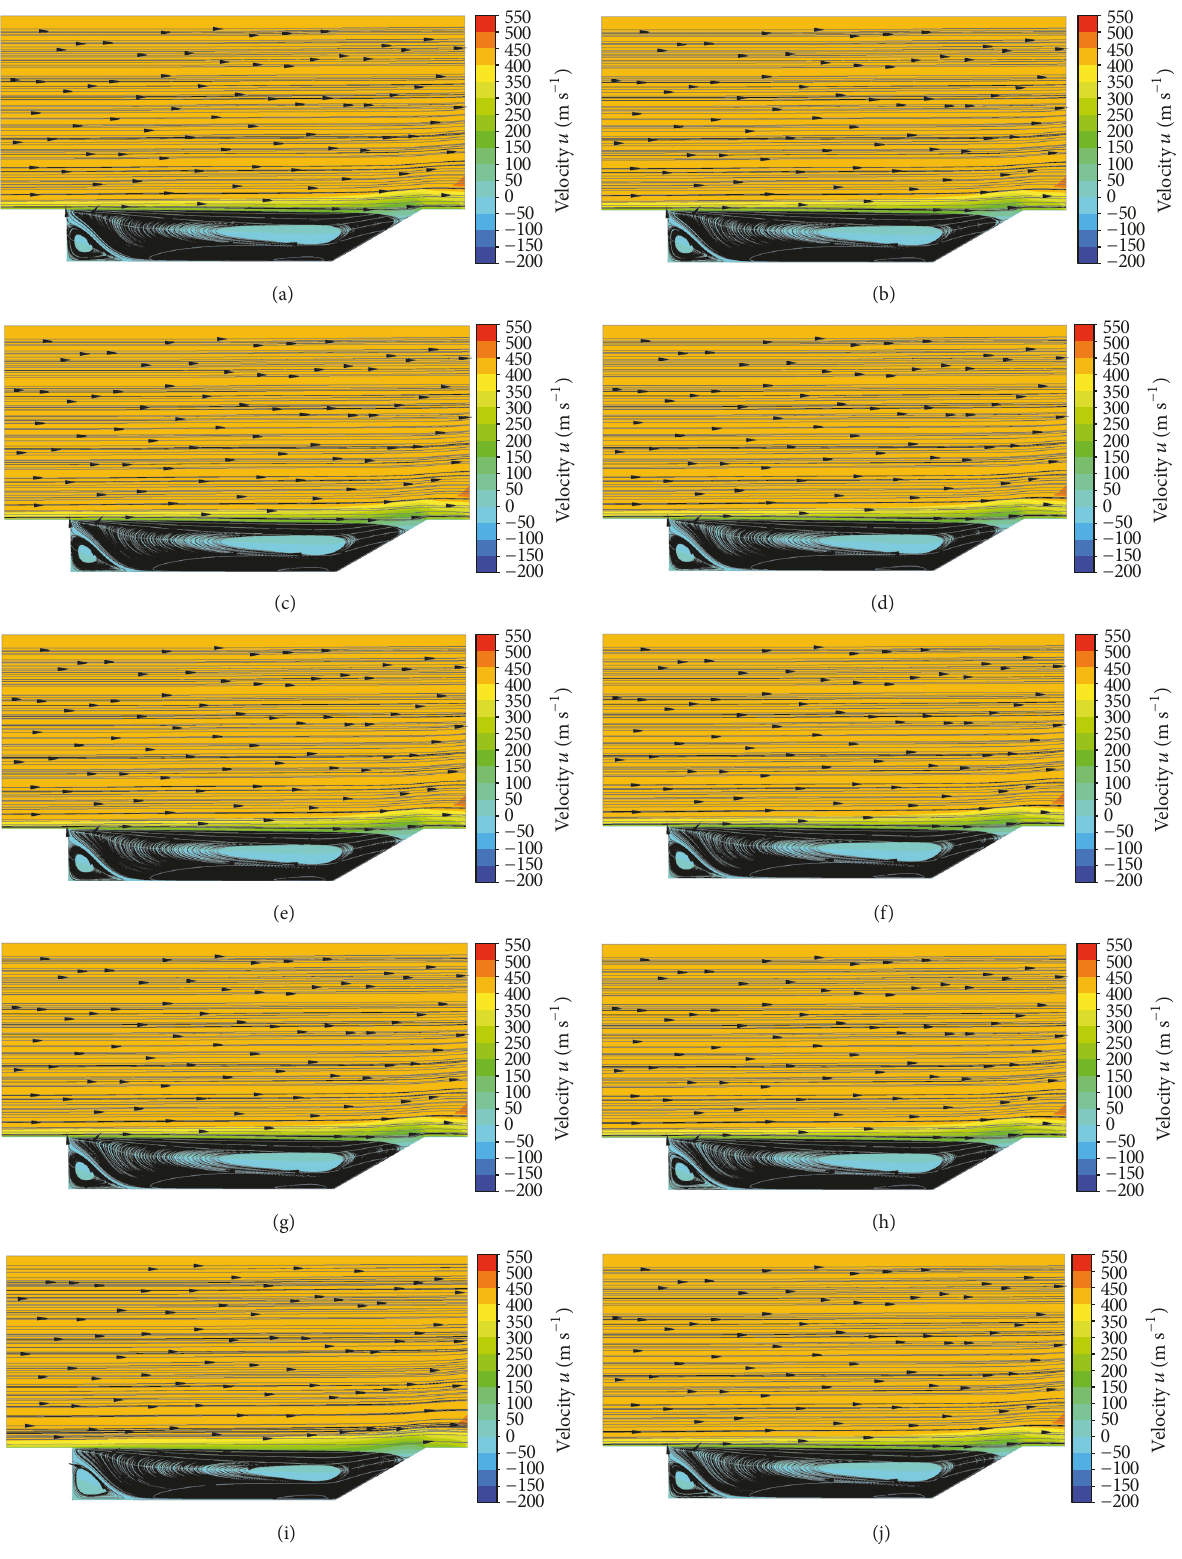
Figure 22: 𝑋 -velocity contours and streamlines for TWM3 case (a) 𝑡/𝑡 𝑅 = 0 , (b) 𝑡/𝑡 𝑅 = 0.11 , (c) 𝑡/𝑡 𝑅 = 0.22 , (d) 𝑡/𝑡 𝑅 = 0.33 , (e) 𝑡/𝑡 𝑅 = 0.44 , (f) 𝑡/𝑡 𝑅 = 0.55 , (g) 𝑡/𝑡 𝑅 = 0.66 , (h) 𝑡/𝑡 𝑅 = 0.77 , (i) 𝑡/𝑡 𝑅 = 0.88 , and (j) 𝑡/𝑡 𝑅 = 1